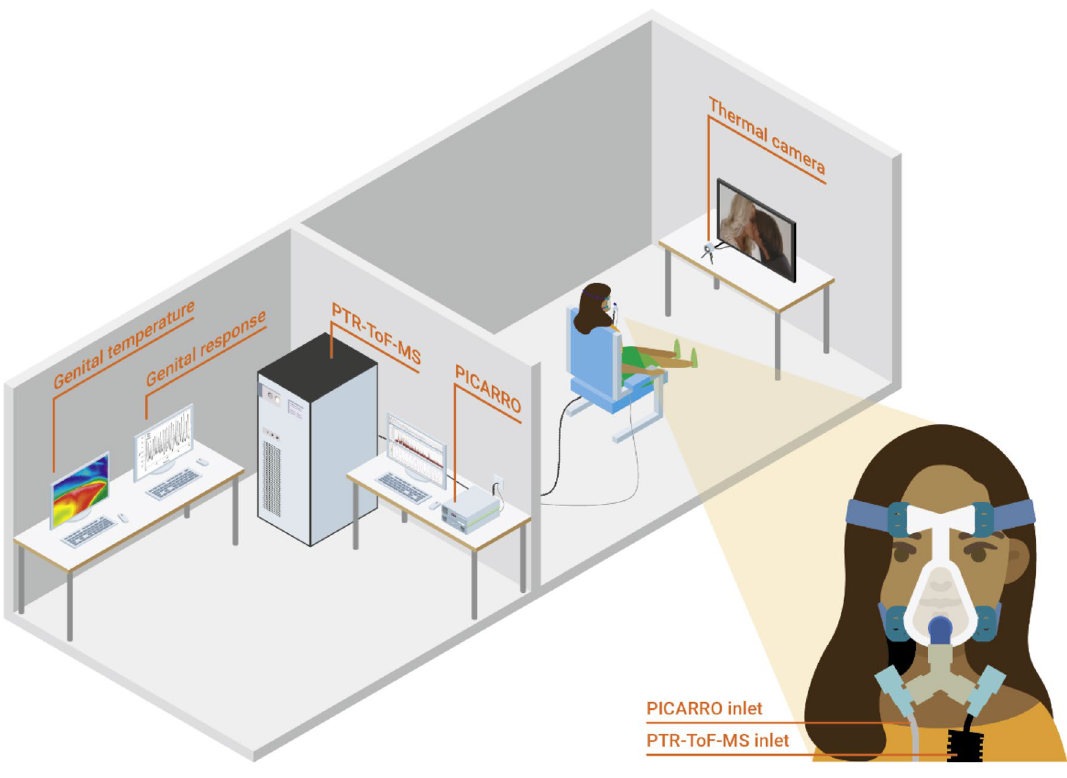
Figure 6. Simplified diagram of the experimental